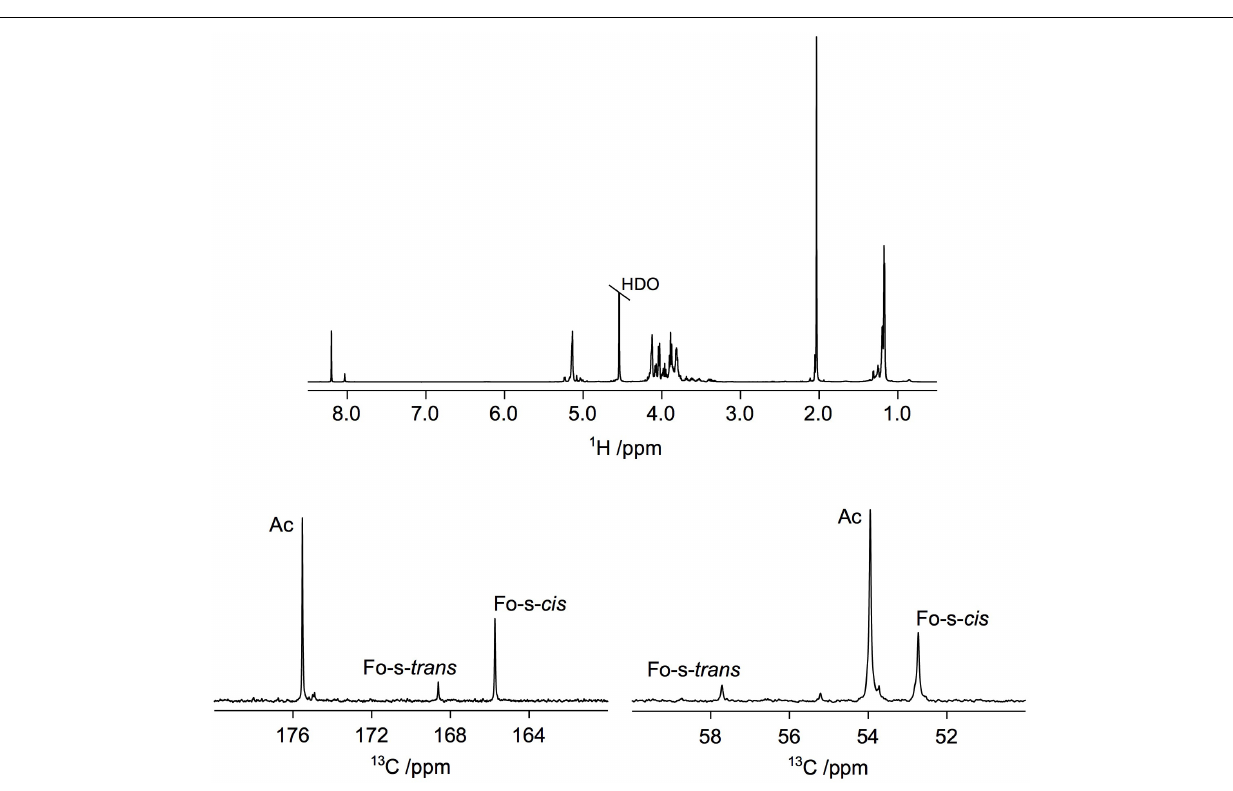
FIGURE 2 | Introduction of wbdR into B. abortus leads to the expression of N -acetyl-perosamine in the O-PS. 1 H NMR spectrum (Top) and selected 13 C NMR spectral regions corresponding to carbonyl region (Lower Left) and region for C4 resonances (Lower Right) of N -formylated and N -acylated perosamine in strain Ba - p